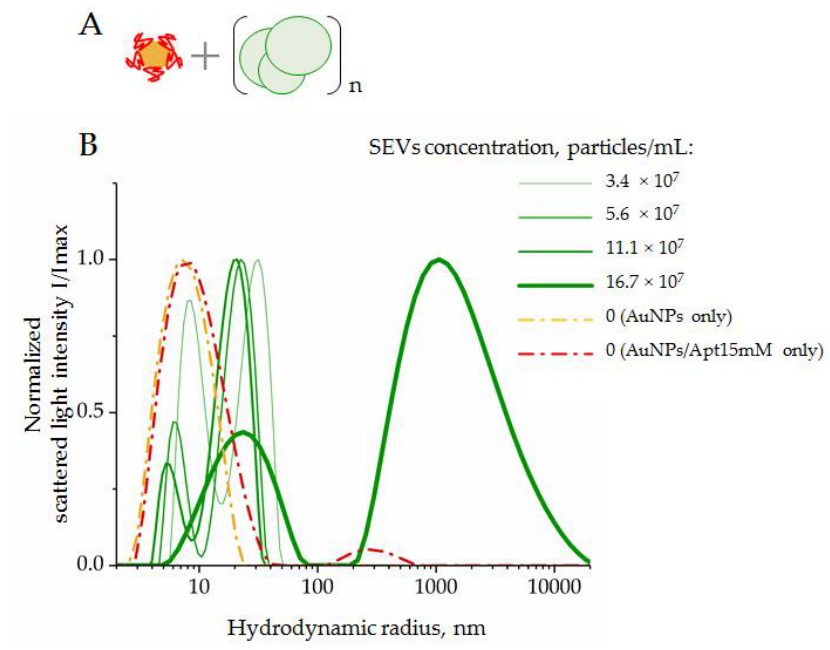
Figure 6. DLS distribution of hydrodynamic radius, R h , of the system components composed by AuNPs complexed with CD63 ssDNA aptamers in a range of SEV concentrations: ( A ) scheme of the experiment; ( B ) results of DLS measurements. AuNP – aptamer complexes were formed at AuNPs (2 × 10 15 particles/mL), and an aptamer concentration of 15 mM was assayed as control.